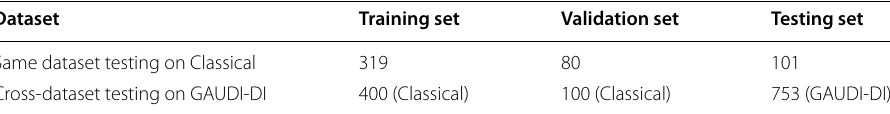
Table 2 Training set, validation set, and testing set on the same dataset and across-dataset